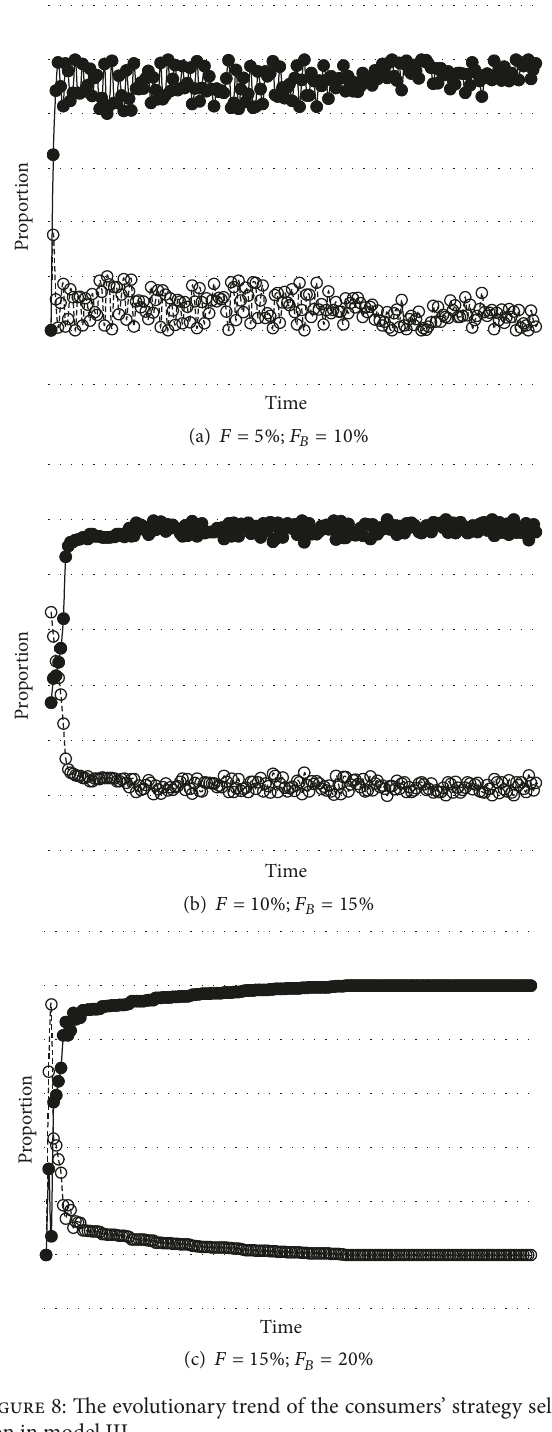
Figure 8: The evolutionary trend of the consumers’ strategy selec- tion in model